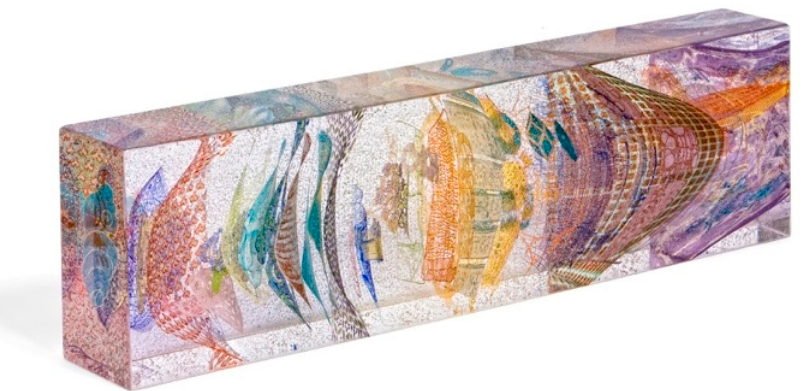
Figure 3. Jeffrey Sarmiento, Encyclopaedia ( Swim ), 2018. Screenprinted, cast and polished glass. Photo: David Williams.